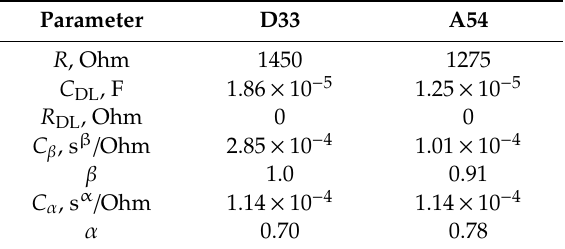
Figure 3. Simple equivalent circuit model of PMSC. Table 1. Parameters of the equivalent circuit model.